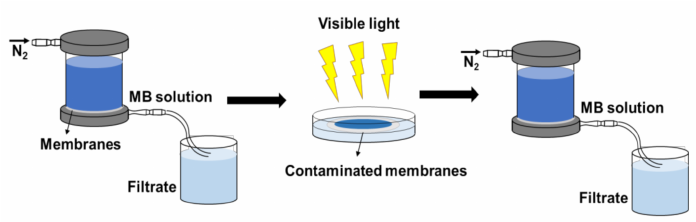
Figure 2. Self-cleaning test process of NF membrane.